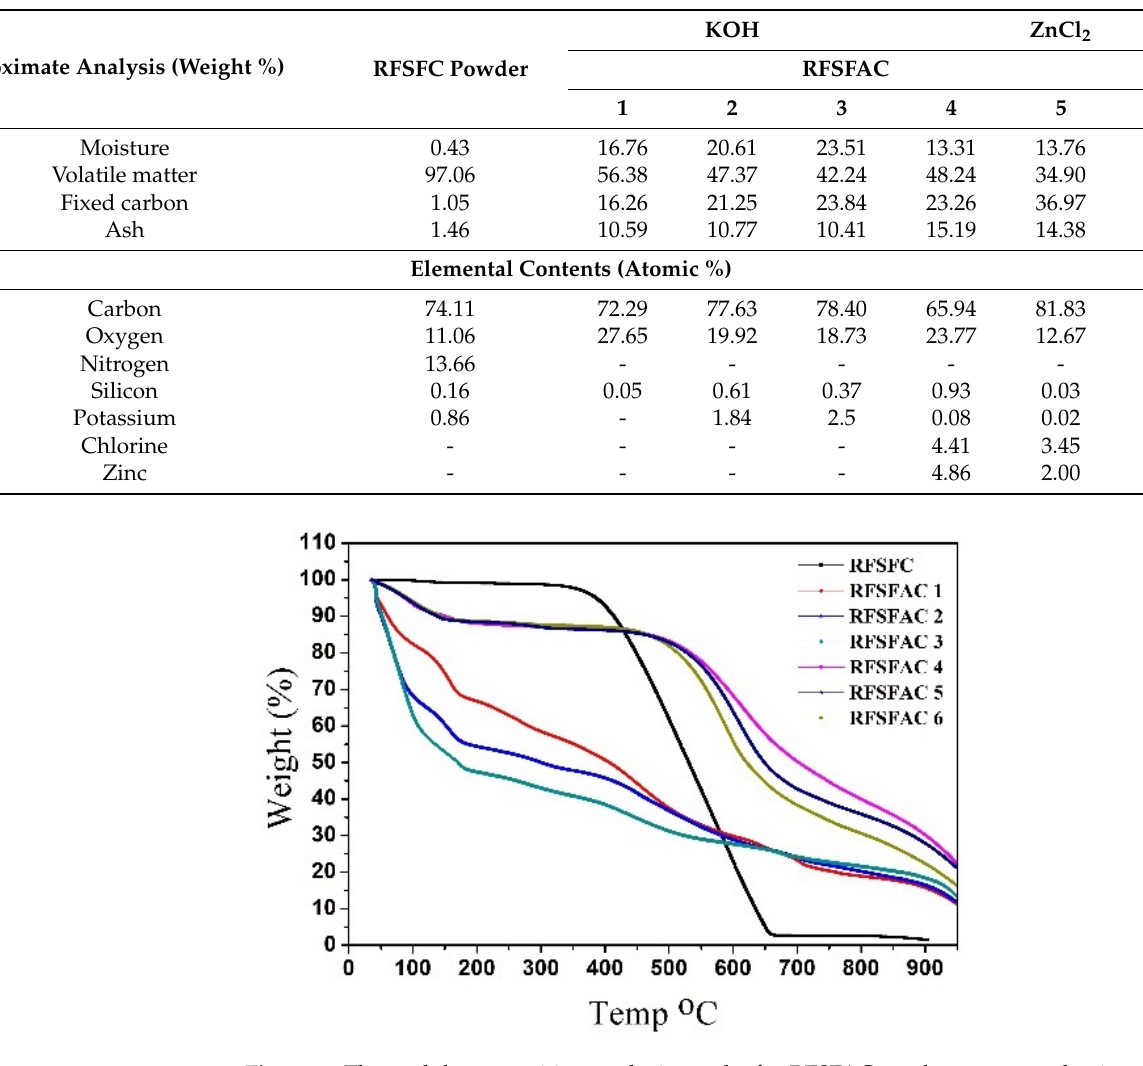
Figure 1. Thermal decomposition analysis results for RFSFAC products prepared using different activating agents and impregnation ratios.